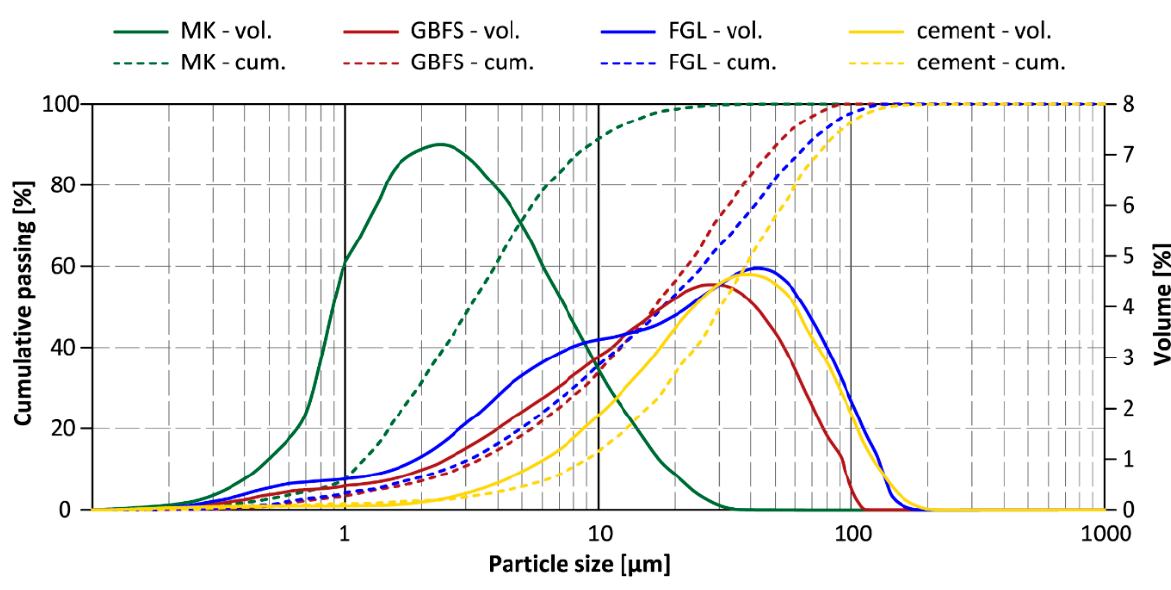
Figure 4. Granulometric curves of used CEM and other powdered components.